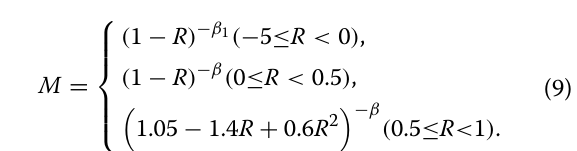
where β and β 1 are constants that depend on the mate- rial properties and environmental conditions, and β 1 1.2 β . For the aluminum alloy and steel, the param- = × eter β is approximately set to 0.7, while for Ti-6Al-4V, it is set to 0.5. Compared with Kujawski’s model, this model not only considers the contribution of the com- pression load, but also provides more accurate results under R > 0.5. More accurate parameters, β and β 1 can be acquired using numerous sets of test data. However, the FCG rate data with varying R -ratios are sometimes inad- equate for engineering materials.